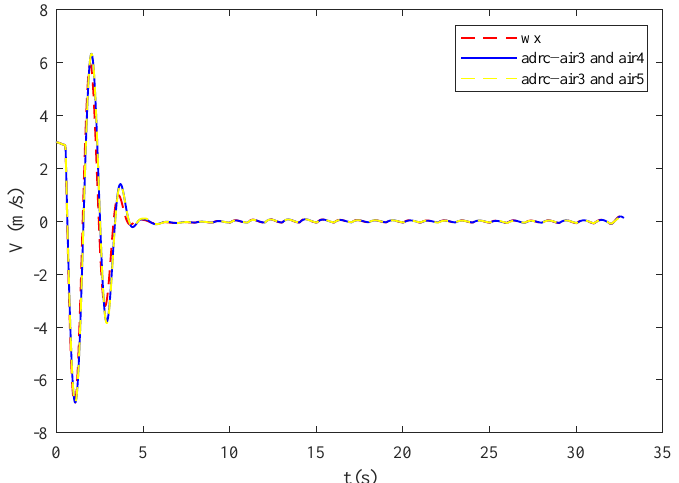
Figure 3. Change curve of roll angle rate under the combination of two steerage